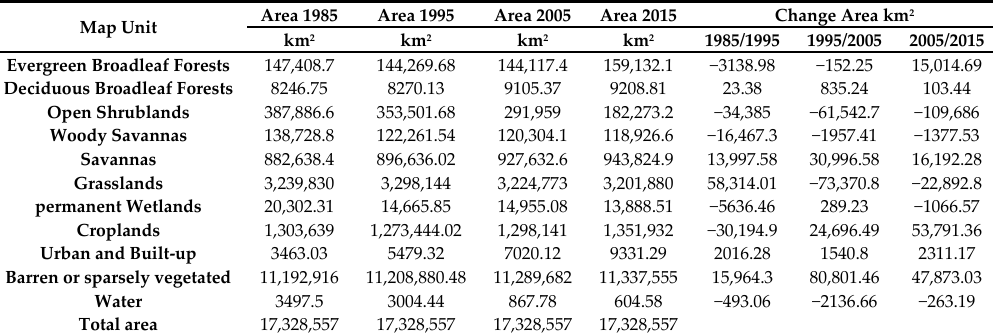
Figure 2. Temporal changes in area of LULC from 1982 to 2015. Table 1. Land cover/land use classes and areas in km 2